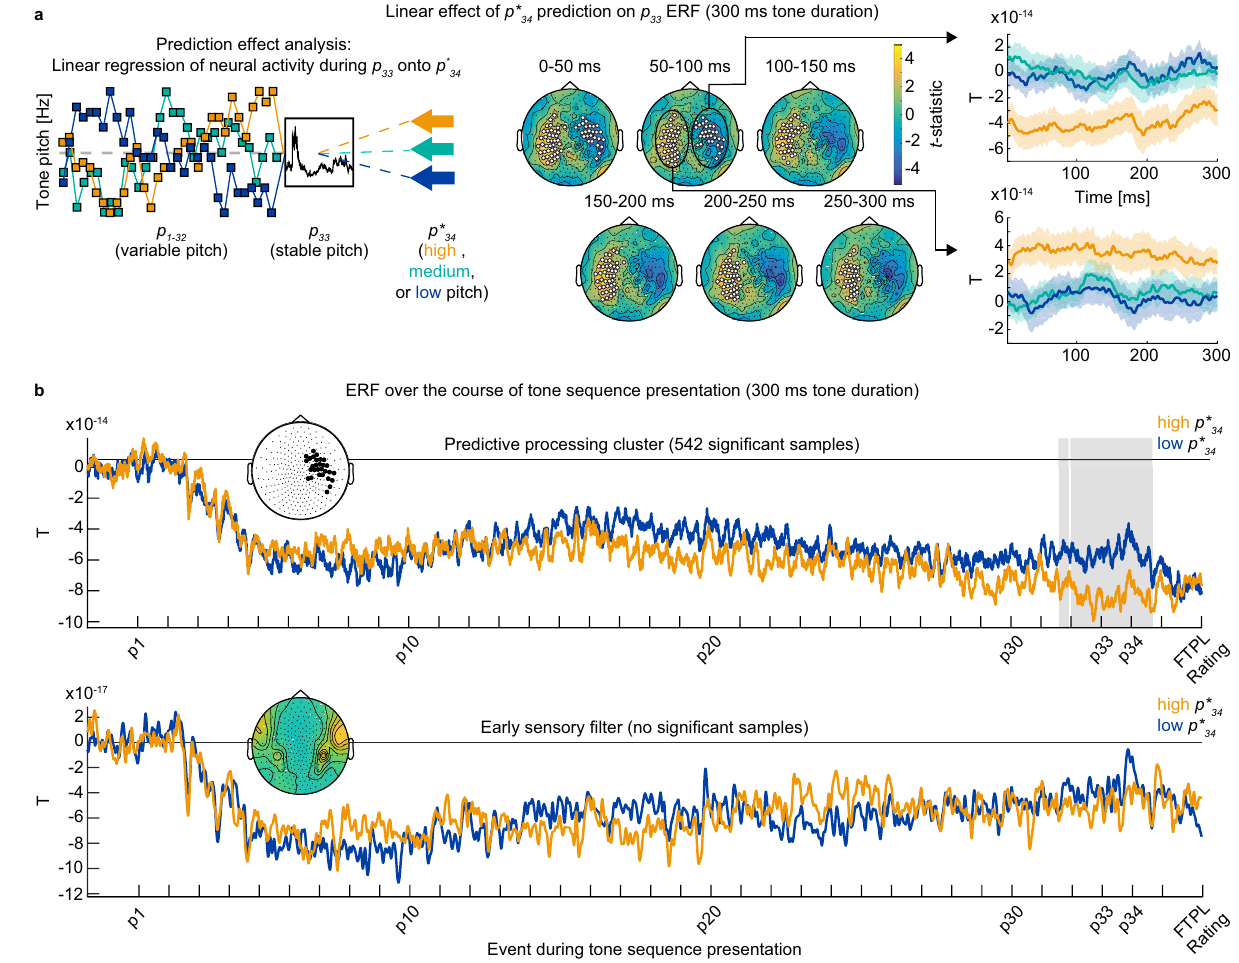
Fig. 3 Slow arrhythmic neuromagnetic activity contains predictive information about upcoming tone pitch ( n = 20 participants). a Prediction analysis schematic and group-level neuromagnetic correlates of theoretically predicted fi nal tone pitch ( p (cid:2) [color-coded]) prediction for data from the 300 ms 34 tone duration condition. Non-baseline-corrected neuromagnetic activity averaged across 50 ms time windows during the penultimate tone ( p 33 ) was regressed onto p (cid:2) to reveal sensor clusters where neuromagnetic activity is predictive of future tone pitch. Topoplots show t -values corresponding to a 34 group-level one-sample t -test on regression coef fi cients for each sensor and time window. White dots indicate signi fi cant predictive processing clusters (all p < 0.05, cluster-based permutation test, two-tailed). Right inset shows neuromagnetic activity (unit: T = Tesla) during p 33 -presentation as a function of p (cid:2) , averaged across sensors for the left (bottom) and right (top) predictive processing cluster de fi ned in the 50 – 100 ms time window. Data are presented 34 as mean ± SEM across participants. b Event-related fi elds (ERF) over the course of tone sequence presentation ( p 1 = tone 1 within the current sequence) for tone sequences with low vs. high p (cid:2) (example shown for data from the 300 ms tone duration condition). Top panel: ERF computed for the right 34 predictive processing cluster de fi ned from the 50 – 100 ms time window (inset and Fig. 3a). Bottom panel: ERF computed for the early sensory fi lter (inset shows corresponding sensor weights). Gray shading indicates signi fi cant differences between trials with low and high p (cid:2) (all p < 0.05, cluster-based 34 permutation test, two-tailed). Data are presented as mean across